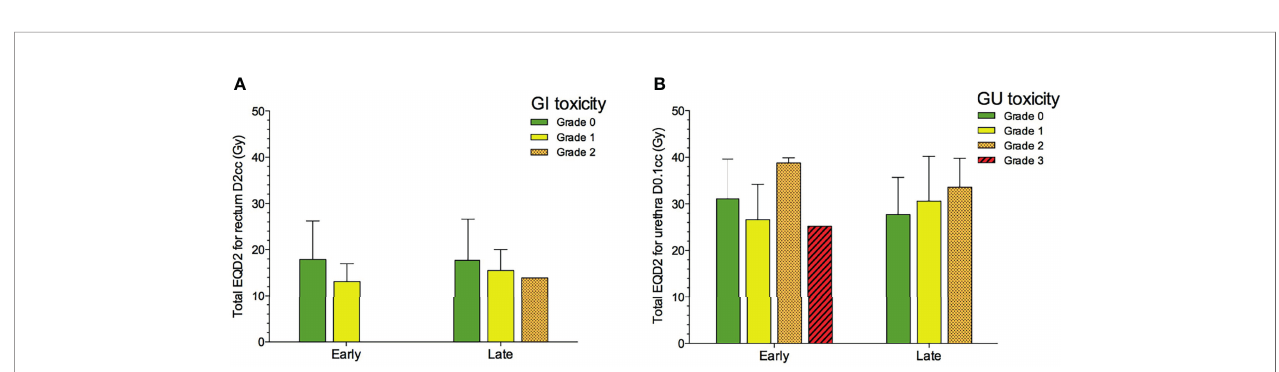
FIGURE 4 | RTOG-graded gastrointestinal (GI) (A) and genitourinary (GU) (B) toxicity before (baseline) and following salvage re-irradiation. RTOG grading ceased if patients received additional local treatment such as HIFU, prostatectomy, or chemotherapy. HDR-BT, High dose-rate brachytherapy; SBRT, Stereotactic body radiotherapy.